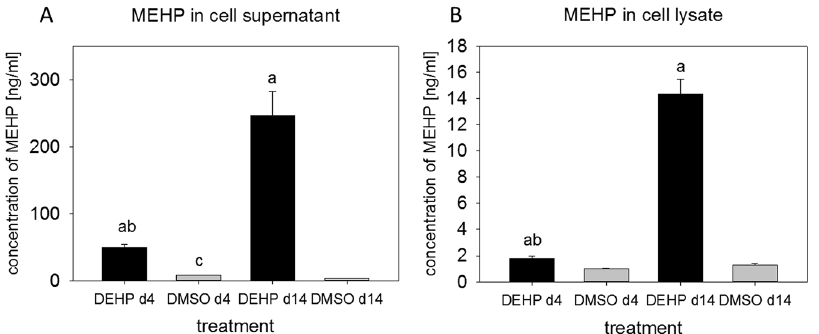
Figure 1. Determination of MEHP in cell supernatants ( A ) and cell lysates ( B ) by HPLC: The SGBS cells were exposed to DEHP [50 µ g/ml] for the whole period of adipogenic differentiation (d0–d14). Samples were taken at d4 and d14 for analysis by HPLC. Statistics: a = DEHP versus corresponding DMSO control; b = DEHP d4 versus DEHP d14; c = DMSO d4 versus DMSO d14; ANOVA (Student-Newman-Keuls Method), significance: p > 0.05; N = 4, n = 1 (4 pooled wells